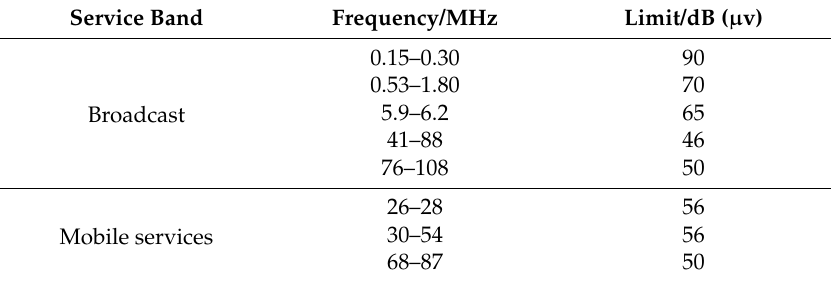
Table 1. CISPR25 class3-peak limits for conducted